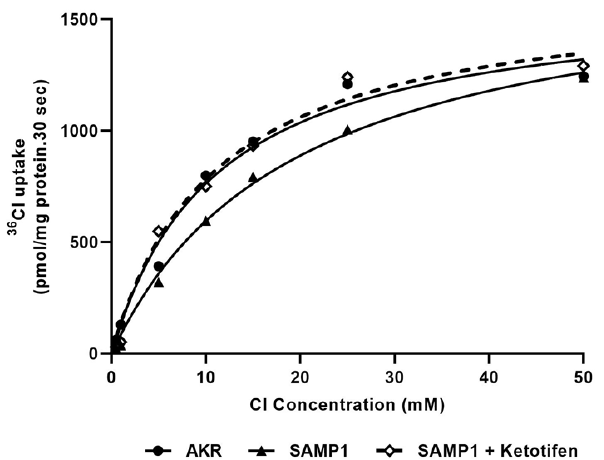
Figure 5. Kinetics of Cl − /HCO 3− exchange in intact intestinal villus cells from AKR, SAMP1 and ketotifen treated SAMP1 mice. HCO 3− -dependent and DIDS-sensitive 36 Cl uptake is shown as a function of varying concentrations of extra vesicular Cl − at 30 s. As the concentration of extra-ve- sicular Cl − was increased, 36 Cl uptake was stimulated and subsequently became saturated in all conditions. Analysis of the data yielded kinetic parameters. In villus cells isolated from SAMP1 mice the Cl − /HCO 3− exchange was inhibited by altering the affinity of the transporter for Cl − and ketotifen treatment significantly reversed the inhibited Cl − /HCO 3− exchange in SAMP1 villus cell by restoring the affinity of the transporter (K m ) without an alteration in the maximal rate of uptake (V max ) of Cl.